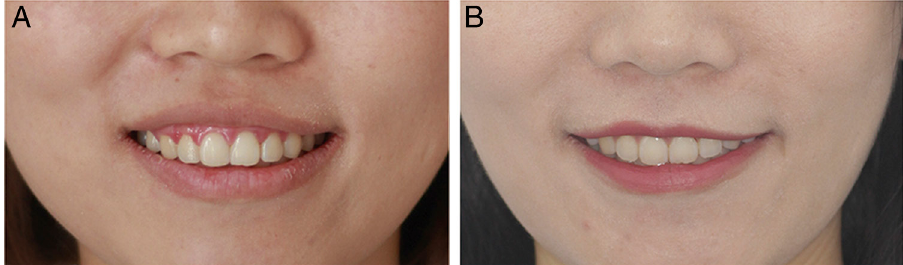
Figure 9. ( A) pretreatment facial smile photograph; (B) posttreatment facial smile photograph: the ‘gummy’ smile was corrected after 3 months’ intrusion of the maxillary anterior teeth.